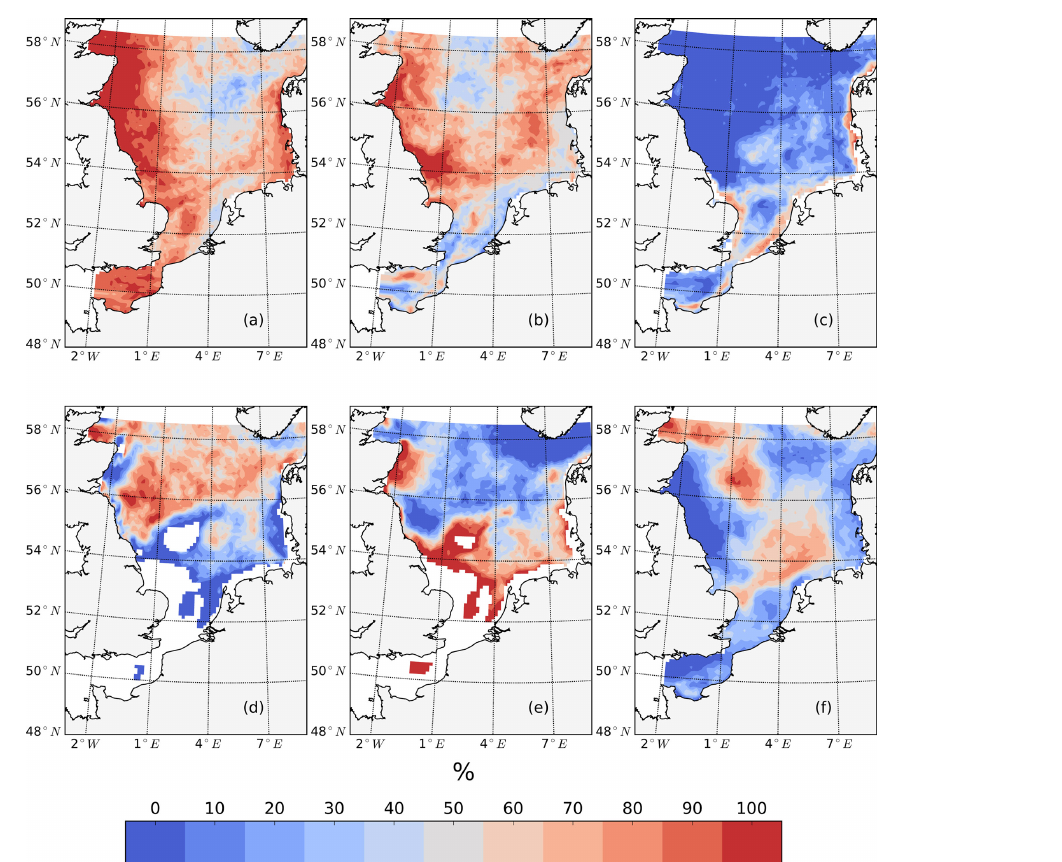
Figure 7. The percentage of years (1990–2015) in which specific processes potentially related to spring bloom phenology changed after considering tides. Changes include a later onset time of the spring bloom (a) , higher peak spring bloom biomass amplitudes (b) , a delay in the onset of light conditions in the water column sufficient for phytoplankton growth, as indicated by an integrated light-limiting term in the upper 50m, exceeds 0.85 (c) , the deepening of the mixed layer depth in May (d) , a later onset time of stratification, which occurs when the maximum vertical temperature difference in the water column exceeds 0.5 ◦ C for 3 consecutive days (e) and a higher concentration of overwintering zooplankton biomass (f)